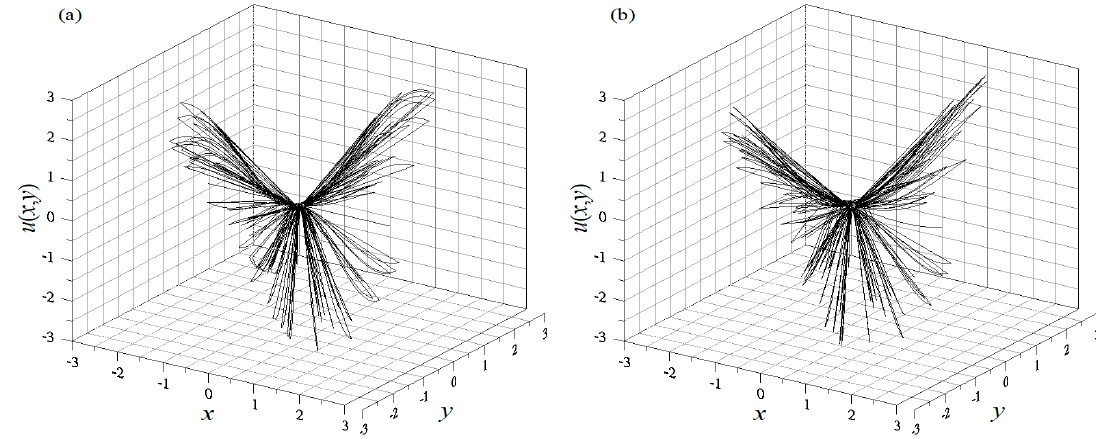
Figure 16. The exact solutions for the steady-state AC equation with irregular gear shaped domain are displayed in ( a ), and in ( b ) the proposed approach solution without random noise.